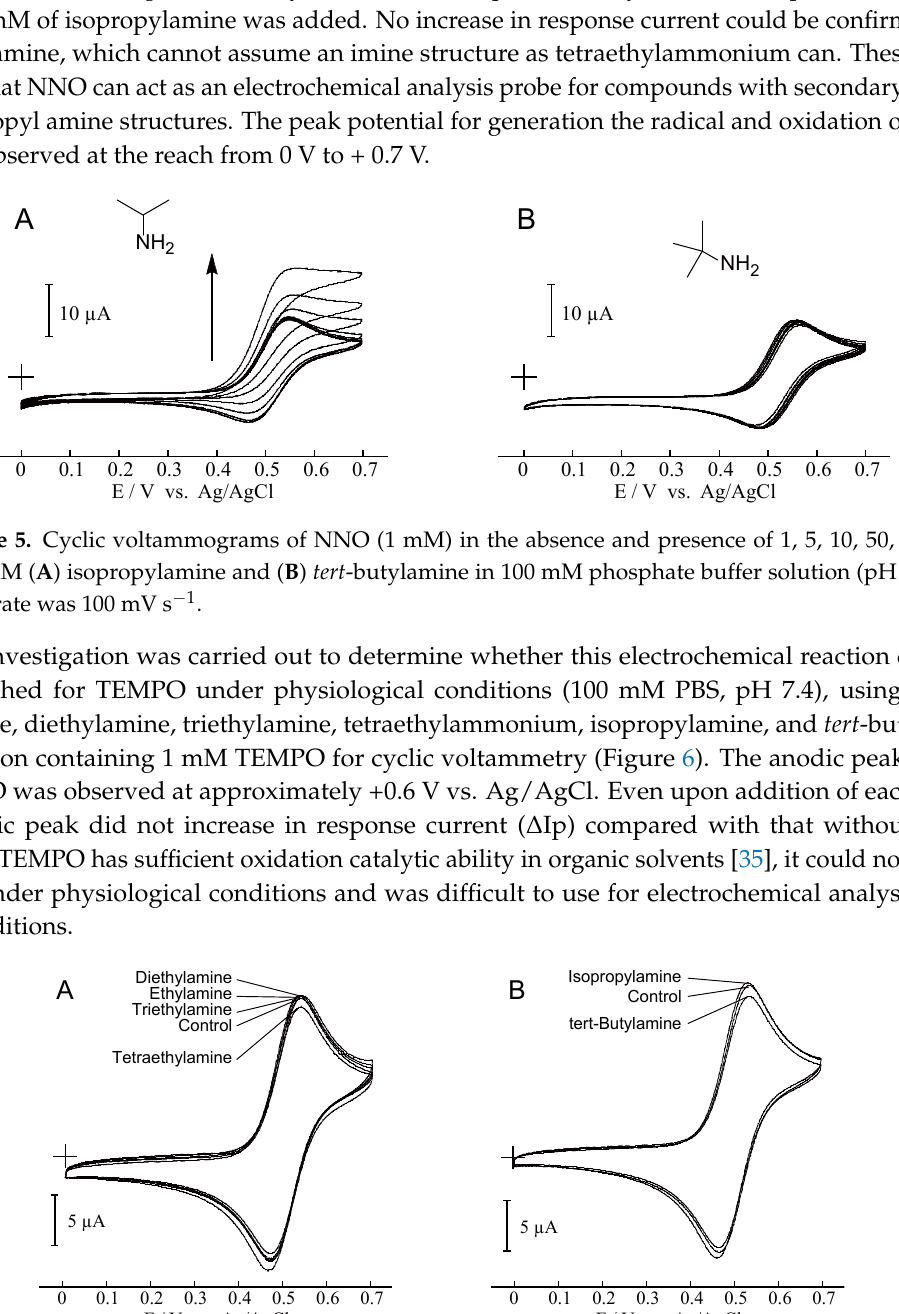
Figure 4. Reaction of NNO and ethylamine.